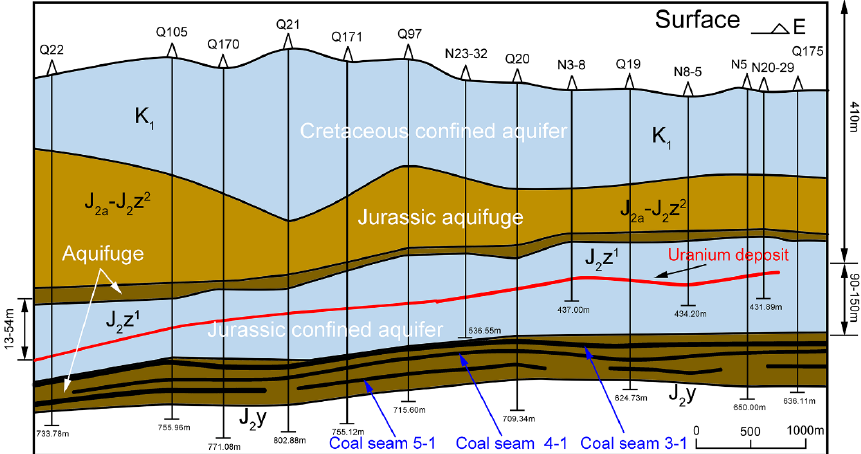
Figure 6. Schematic of the co ‐ existence situation between coal and uranium in the Tarangaole mine area of the Haggin banner in the Ordos Basin. area of the Haggin banner in the Ordos